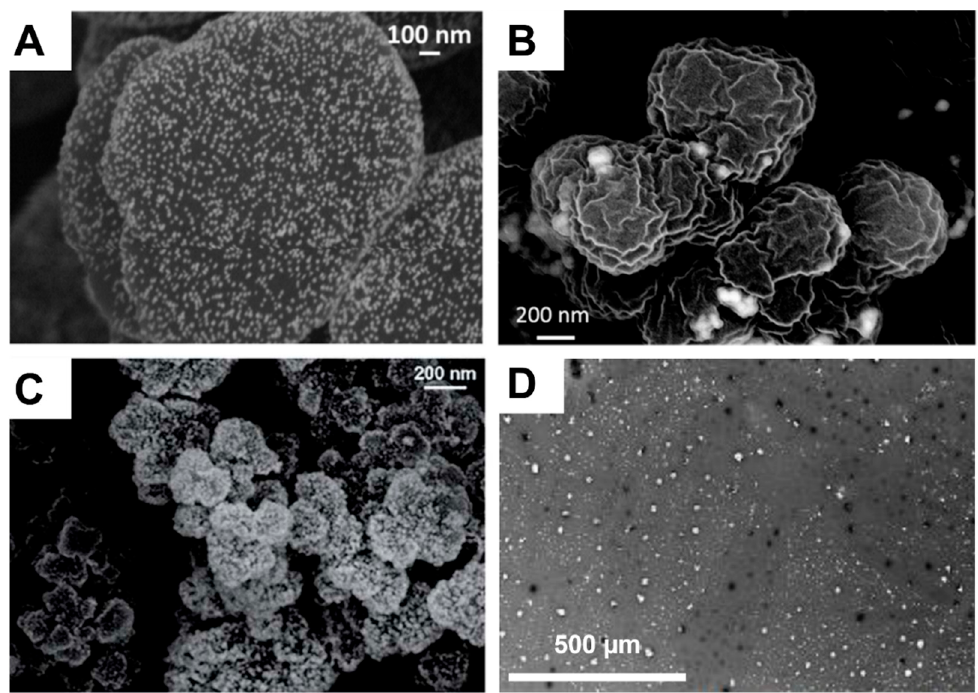
Figure 9. ( A ) Ex situ generated Au NPs supported on a NAS-based capillary monolith. [58], Copyright 2017. Reproduced with permission from the Royal Society of Chemistry; ( B ) ex situ generated Cu NPs supported on a NAS-based monolith. [59], Copyright 2015. Reproduced with permission from Elsevier Ltd.; ( C ) in situ generated Pt NPs supported on a GCMA-based monolith. [60], Copyright 2016. Reproduced with permission from the Royal Society of Chemistry; and ( D ) Au NPs supported on a porous cellulose membrane. [66], Copyright 2017. Reproduced with permission from Wiley-VCH Publishers.